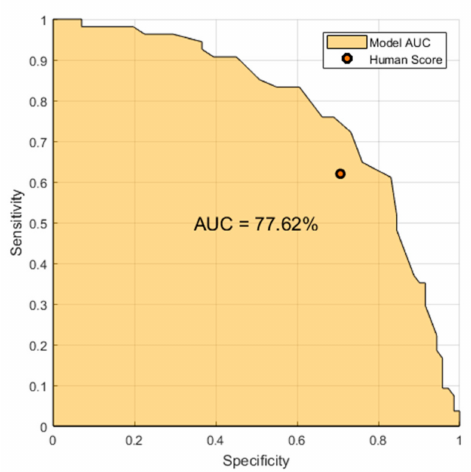
Figure 9. Best-model AUC vs. human sensitivity-specificity.